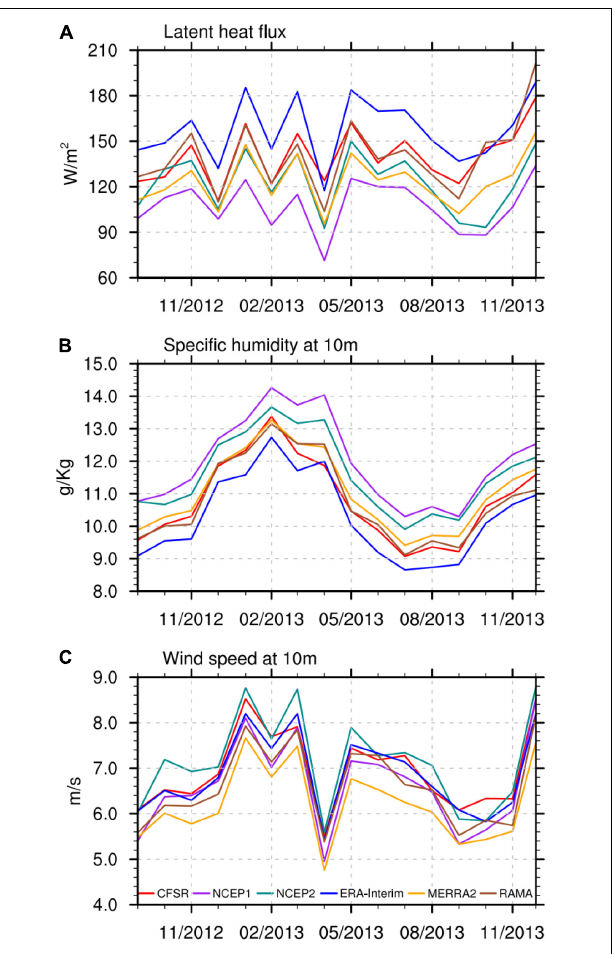
FIGURE 4 | (A) Comparison of monthly mean latent heat flux from EX-alg with those from the RAMA buoy at 100 ◦ E, 25 ◦ S. The positive values indicate the flux from the ocean to the atmosphere. (B) Comparison of Specific humidity at 10 m from reanalysis with those from RAMA buoy at the same location. (C) Same as in (B) , but for wind speed at 10